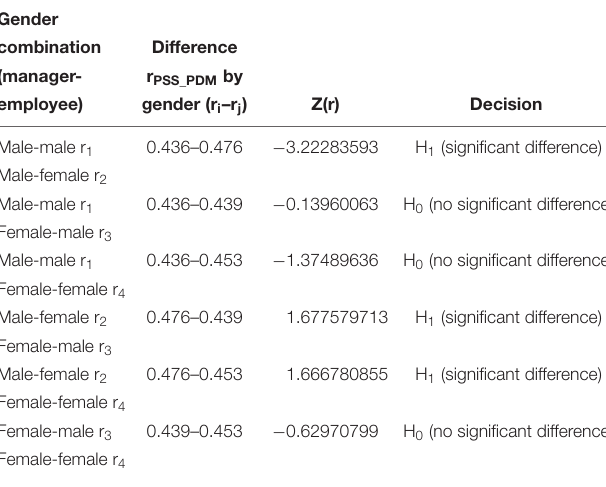
TABLE 6 | Hypothesis test about the difference between linear correlation coefficients of PDM and PSS according to gender dyad composition (Fisher’s Z